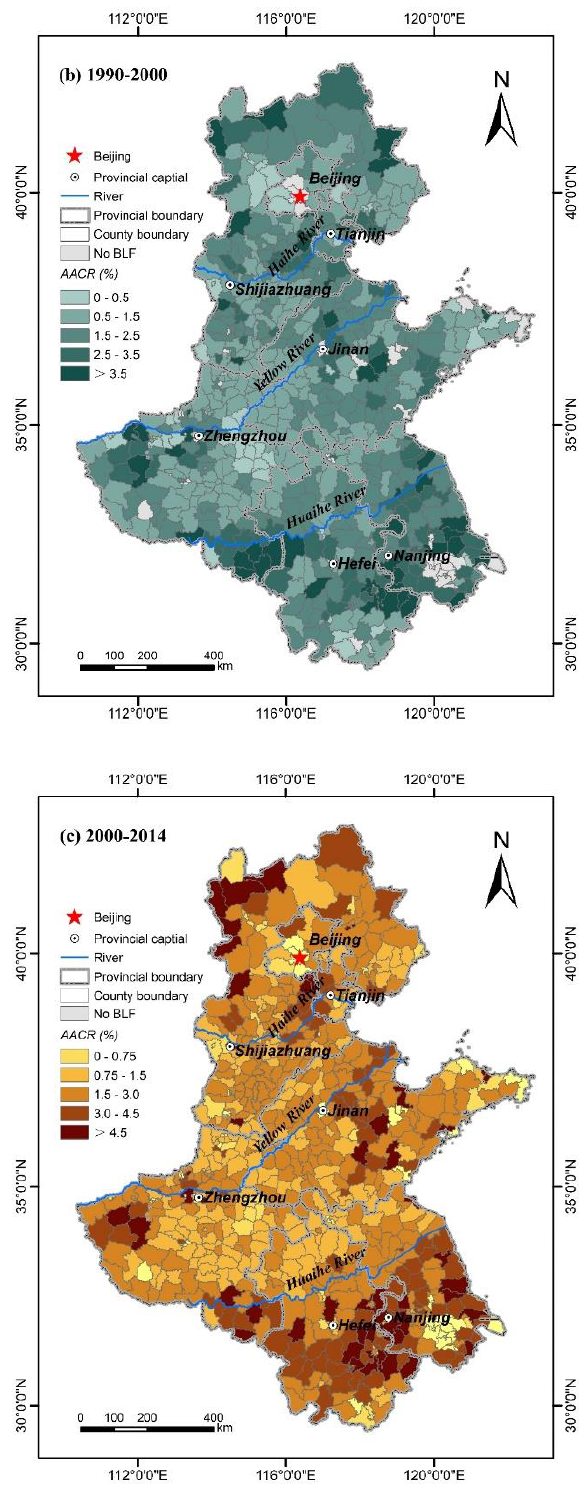
Figure 8. Average annual change rates (AACR) of the built-up land in floodplains (BLF) in different periods: ( a ) 1975–1990; ( b ) 1990–2000; and ( c ) 2000–2014.